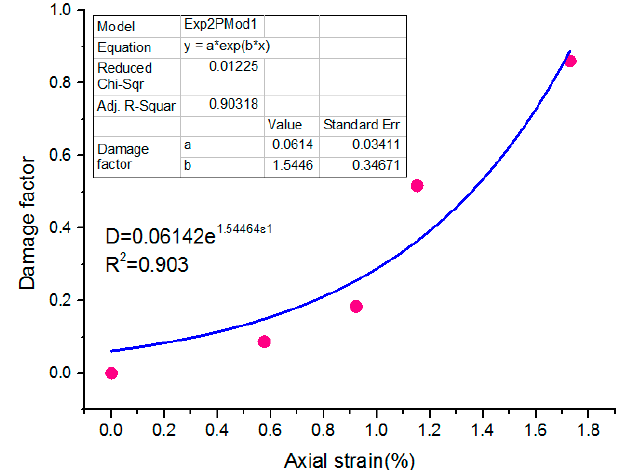
Figure 11. Plot of the damage factor against the axial strain. This was plotted to attain the damage evolution equation. Table 3. Stress, strain, and mean of the CT value and the damage factor of the CWRB sample.